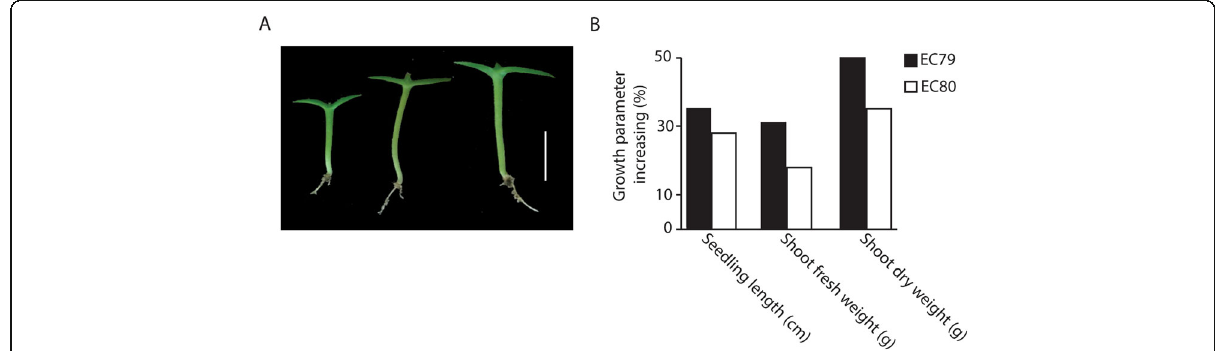
Fig. 3 Endophytic bacteria improve the growth parameters of pitaya plants in greenhouse trials. a Presentative for increasing the seedling length. b Improvement of plant biomass. Mean percentage increases of in vivo plant growth parameters for the most effective endophytic bacterial strains assessed in this study; scale bar 1